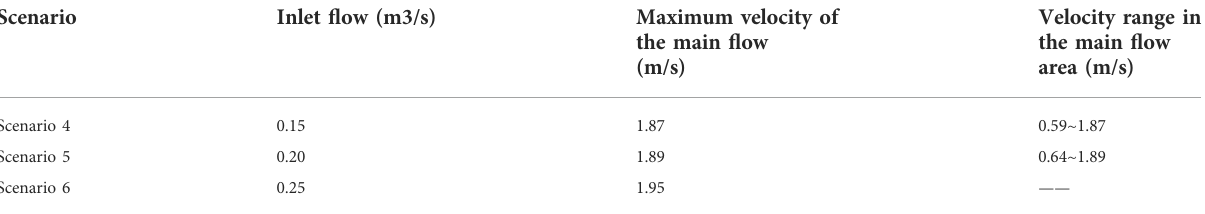
TABLE 6 Calculation results of fl ow rate under different scenarios.